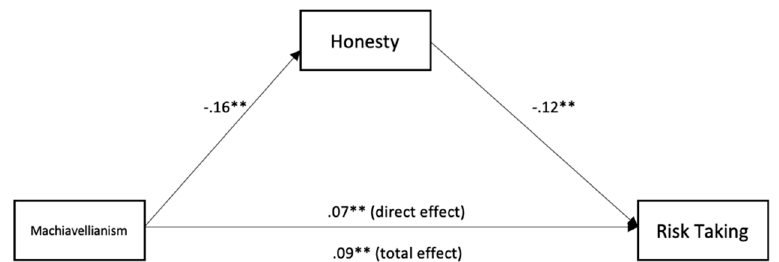
Figure 1. Mediation analysis for the relationship between Machiavellianism, altruism, and risk- taking . * p< 0.05 ; ** p < 0.01.